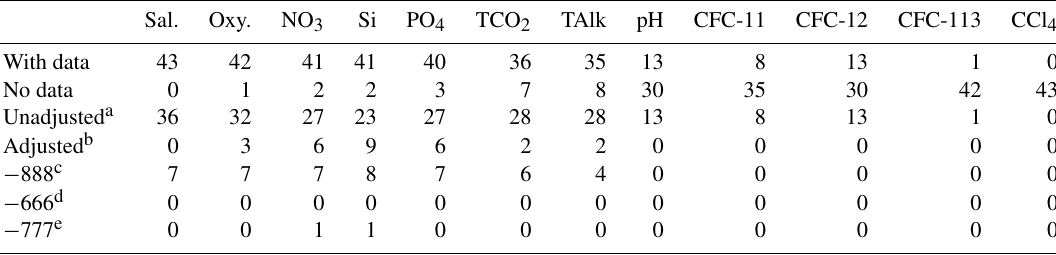
Table 5. Possible outcomes of the secondary QC and their codes in the online adjustment table. Secondary QC result Code The data are of good quality, are consistent with the rest of the dataset, and should not be adjusted. The data are of good quality but are biased: adjust by adding (for salinity, TCO 2 , TAlk, pH) or by multiplying (for oxygen, nutrients, CFCs) the adjustment value. The data have not been quality controlled, are of uncertain quality, and are suspended until full secondary QC has been carried out. without crossovers or similar, prohibits full secondary QC.